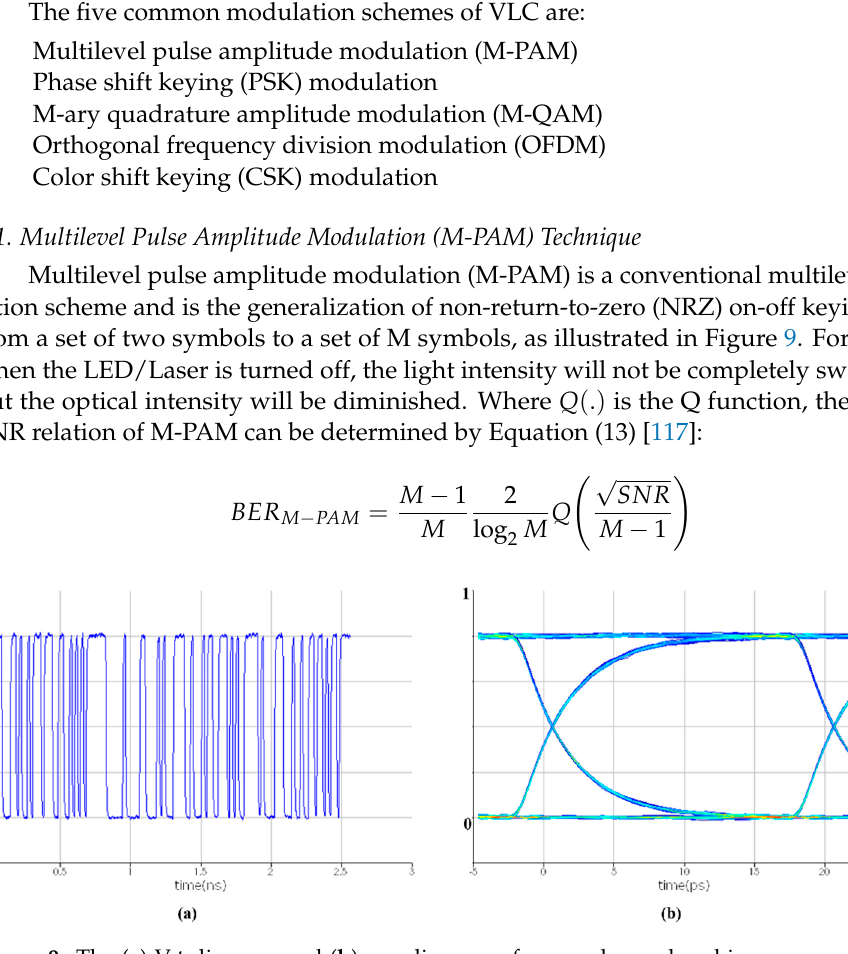
Figure 10. Signal-space constellation of discrete PM: ( a ) binary PSK, ( b ) quadrature binary PSK, ( c ) eight PSK and ( d ) phase of the carrier under modulation with π phase shift of the BPSK at the edge of the pulse period. From: [119] , Copyright © 2015 and Imprint. Reproduced by permission of Taylor & Francis Group through PLSclear. 4.3. M-ary Quadrature Amplitude Modulation (QAM) Technique QAM combines both PSK and amplitude-shift keying by changing the two param- eters of the carrier. For that reason, this method is also known as amplitude phase keying